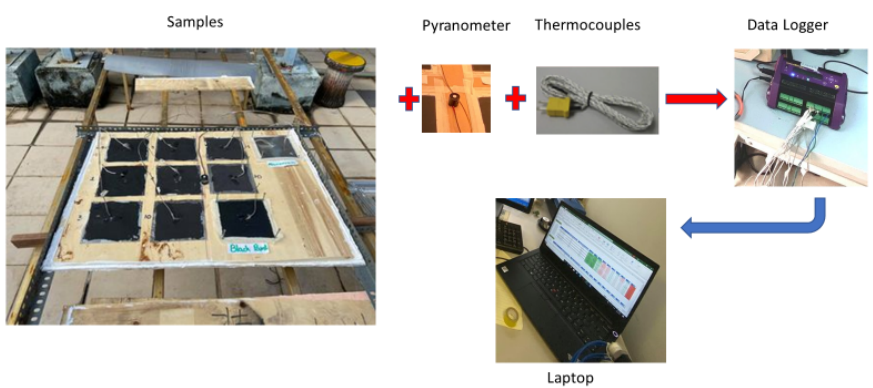
Figure 4. Setup of the outdoor experiment.